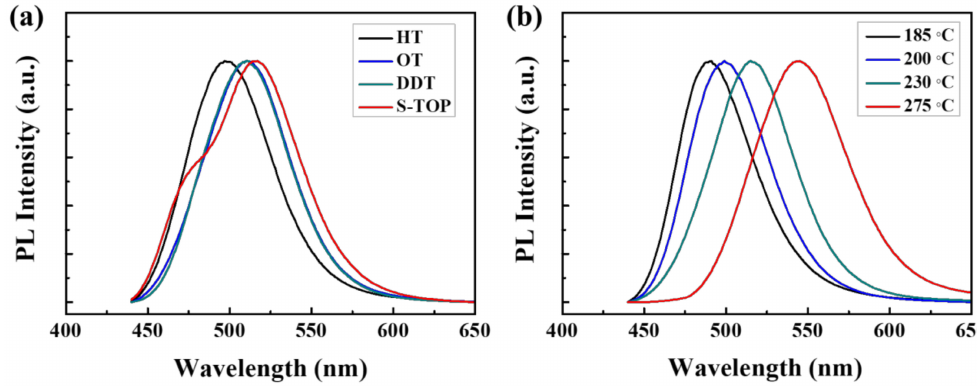
Figure 2. Photoluminescence emission spectra of the QDs prepared ( a ) with di ff erent sulfur sources (injected at 230 ◦ C under the same reaction conditions) and ( b ) at di ff erent injection temperatures of octanethiol.